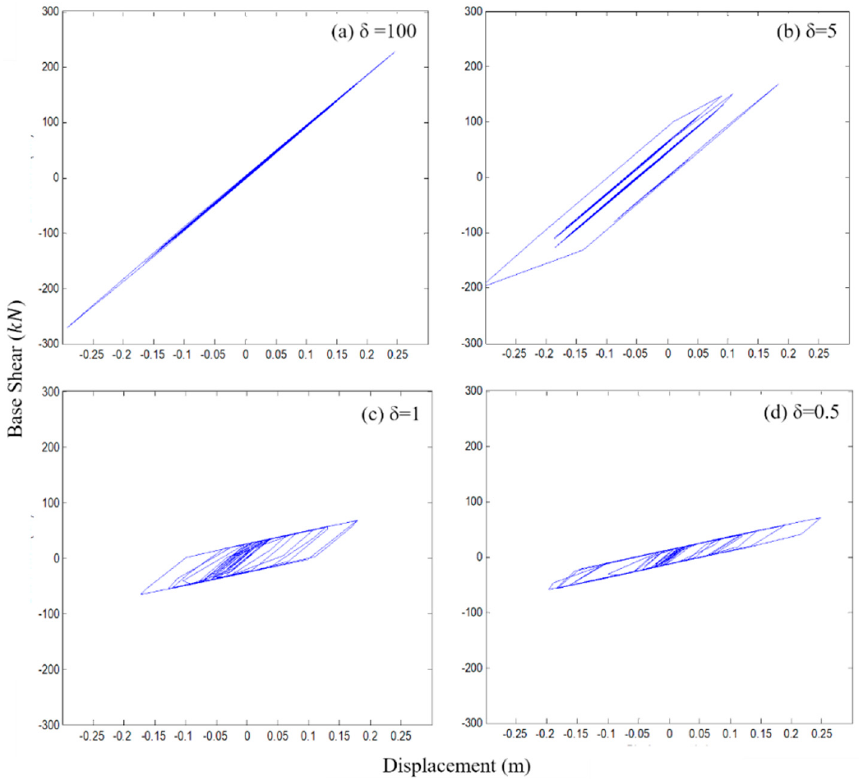
Figure 11. Hysteresis loop of hinge (T = 1.14 s, ξ = 0.05).